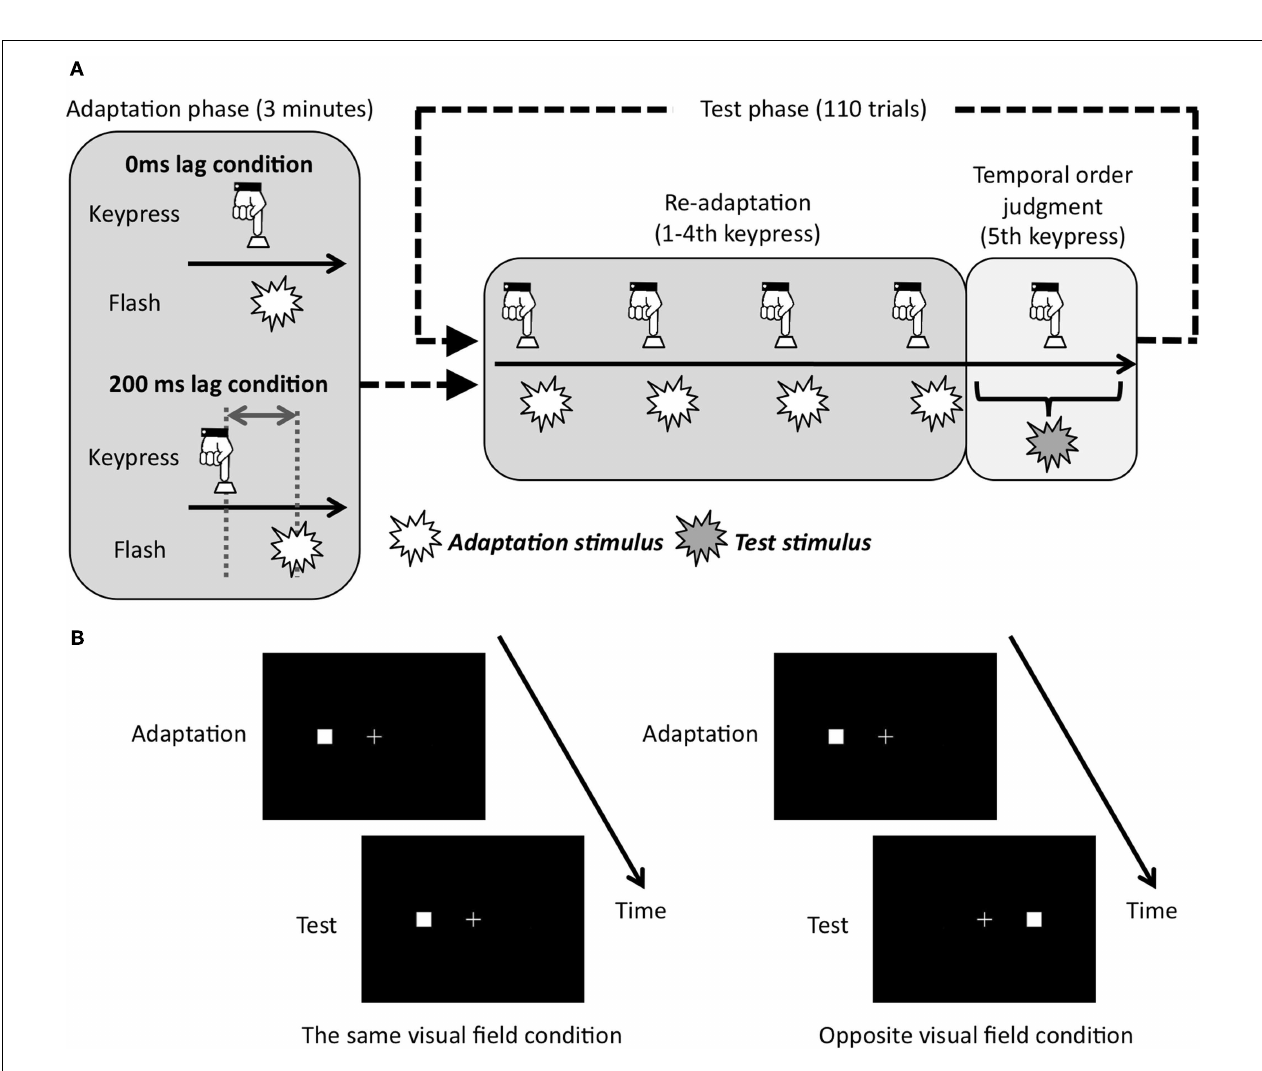
Test visual field conditions. In case the adapted visual field was left, the test visual field was left in the same visual field condition, and was right in opposite visual field